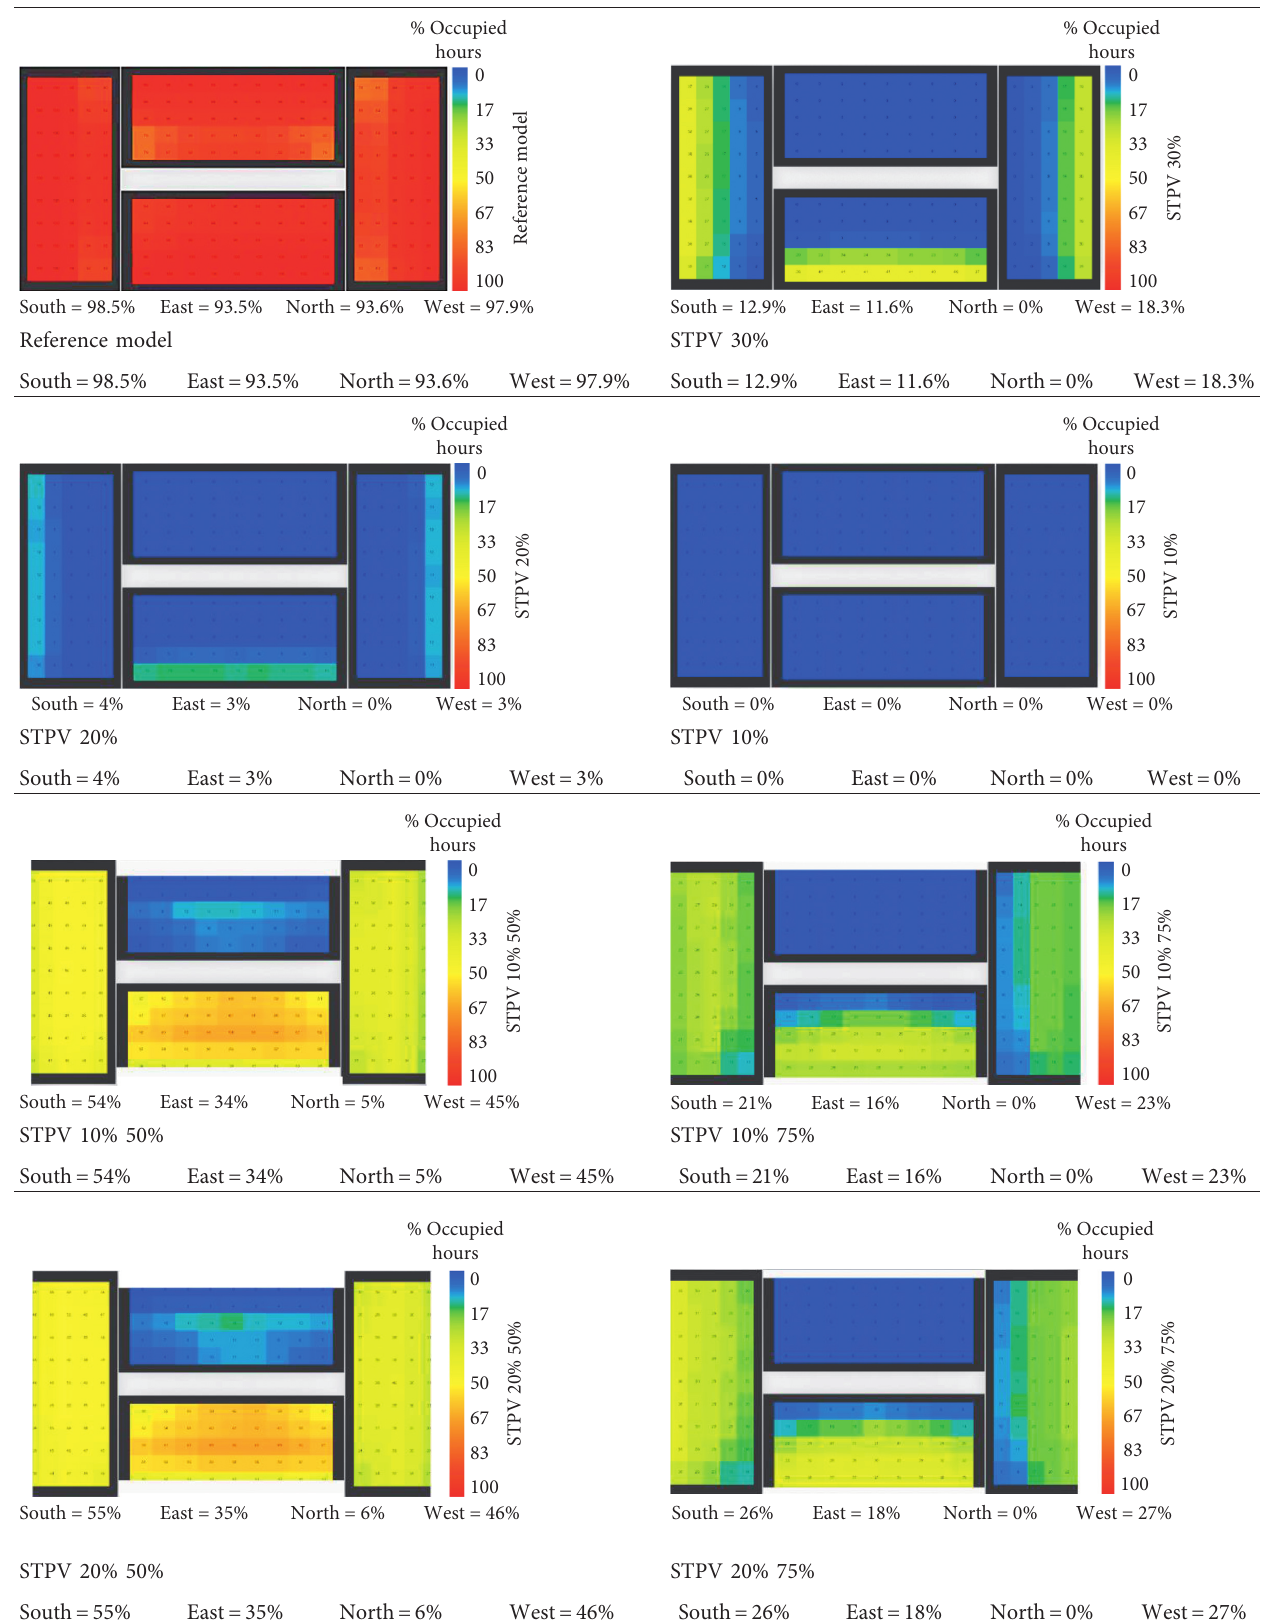
Table 9: DA300 lux distribution of fully glazed open office in cardinal orientations